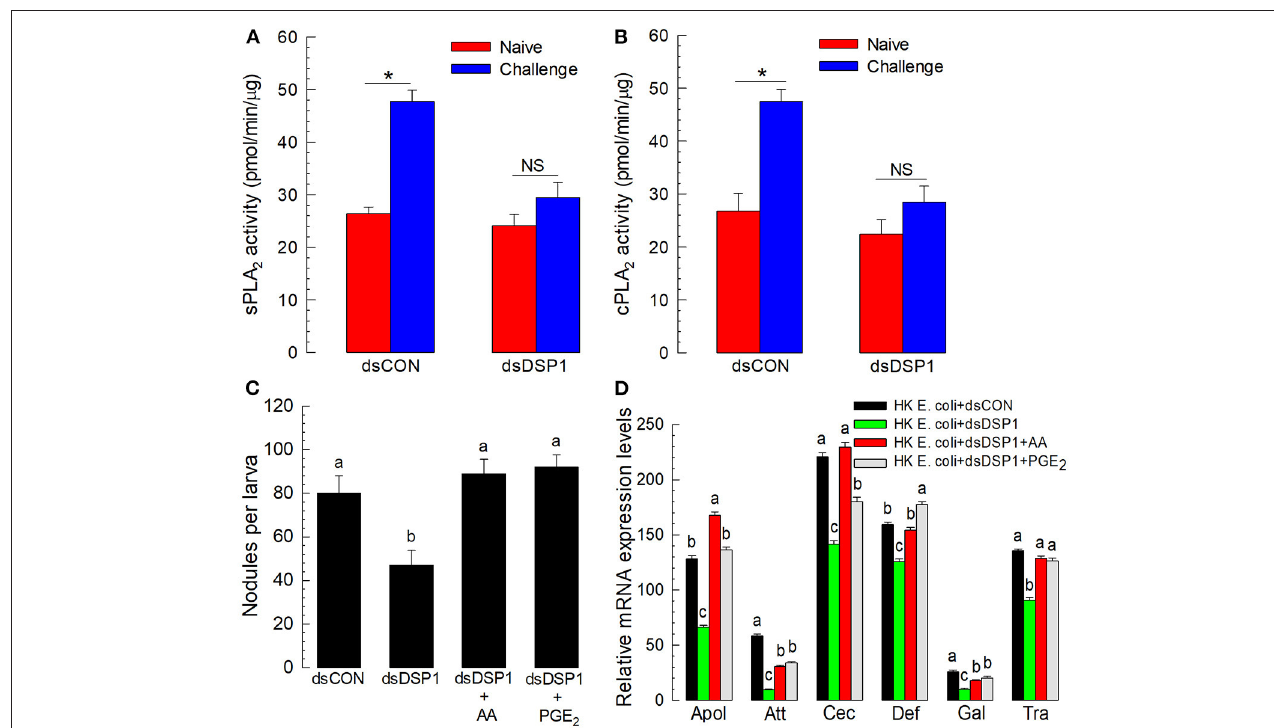
FIGURE 3 | Se-DSP1 activates eicosanoid biosynthesis to mediate the cellular and humoral immune responses of S. exigua . The suppression of bacteria-induced (A) secretory phospholipase A2 (sPLA 2 ) and (B) cellular PLA2 (cPLA 2 ) activities by RNAi specific to Se-DSP1 expression. A viral gene, CpBV302 , was used as a control dsRNA (“dsCON”). For the immune challenge, each of the L5 larvae was injected with 4.5 × 10 4 HK E. coli cells 24h after an injection with dsRNA specific to Se-DSP1 (dsDSP1) (1 µ g per larva). At 8h after the immune challenge, fat bodies were collected and used for enzyme assays. An asterisk on SD bars indicates a significant difference among means at Type I error = 0.05 (LSD test). “NS” stands for no significant difference. (C) the rescue effect of eicosanoids on immune responses suppressed by RNAi treatment in hemocytic nodule formation. (D) Antimicrobial peptide (AMP) gene expression. Arachidonic acid (AA) or prostaglandin E 2 (PGE 2) at a dose of 10 µ g per larva was injected along with HK E. coli (4.5 × 10 4 cells per larva) 24h post dsRNA injection,. Nodule formation was assessed, and fat body tissues were collected and used to analyze AMP gene expression 8h after E. coli injection. A ribosomal protein, RL32 , was used as an internal control. Each treatment was replicated three times. Different letters above standard deviation bars indicate significant difference among means at Type I error = 0.05 (LSD